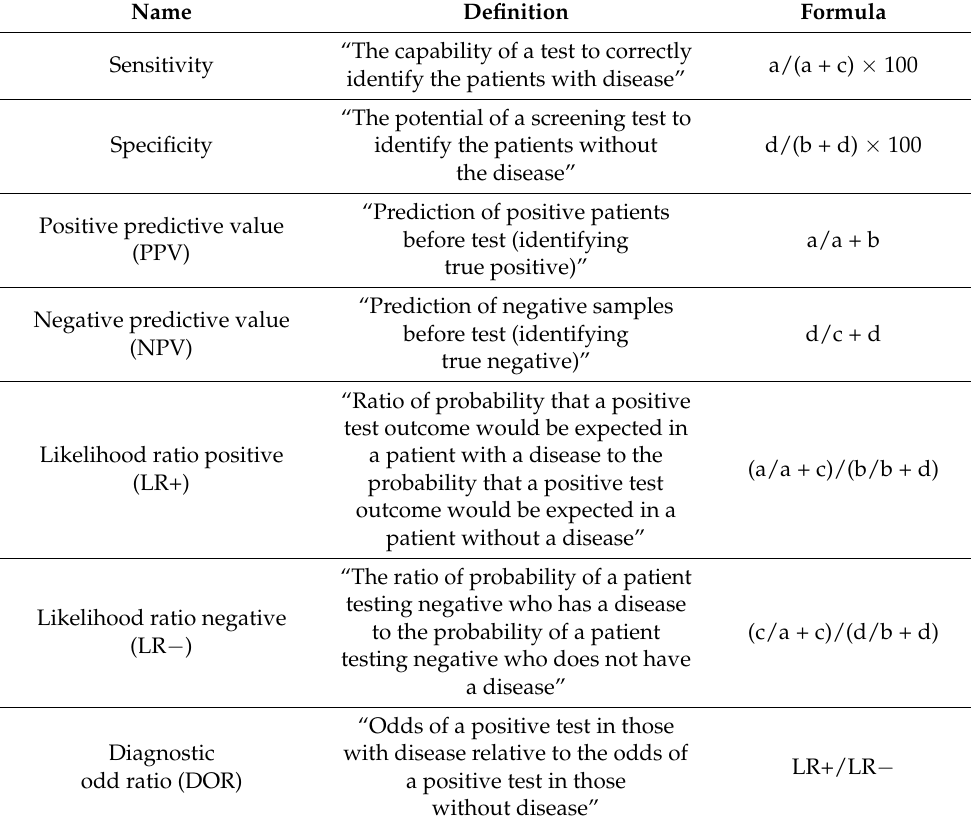
Table 1. Definition and formulas to calculate sensitivity, specificity, PPV, NPV, LR+, LR − and DOR of ELISA, based on